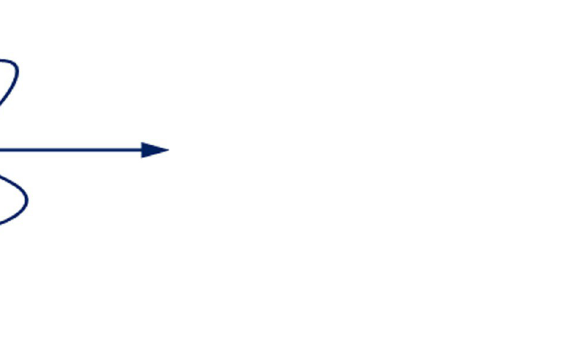
Fig 1. A schematic diagram of butterfly plastic